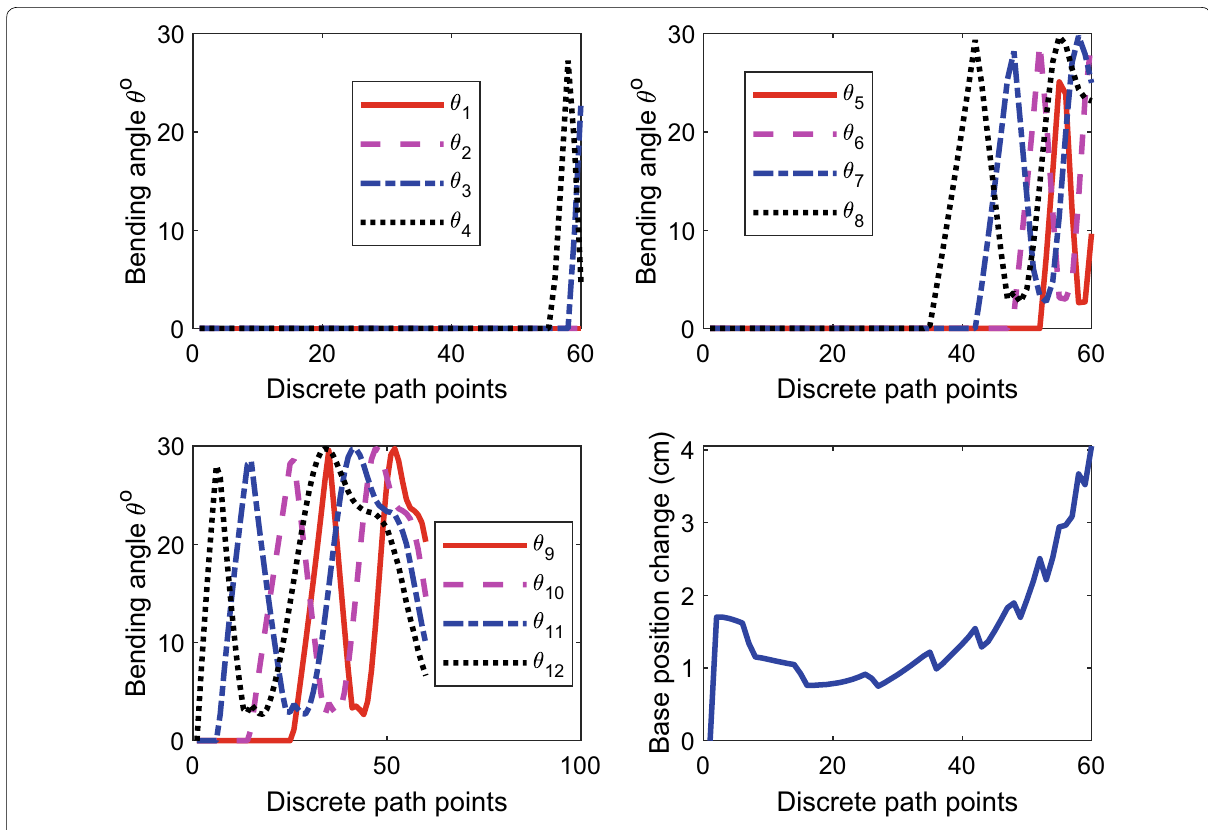
Figure 9 Bending angles and base position